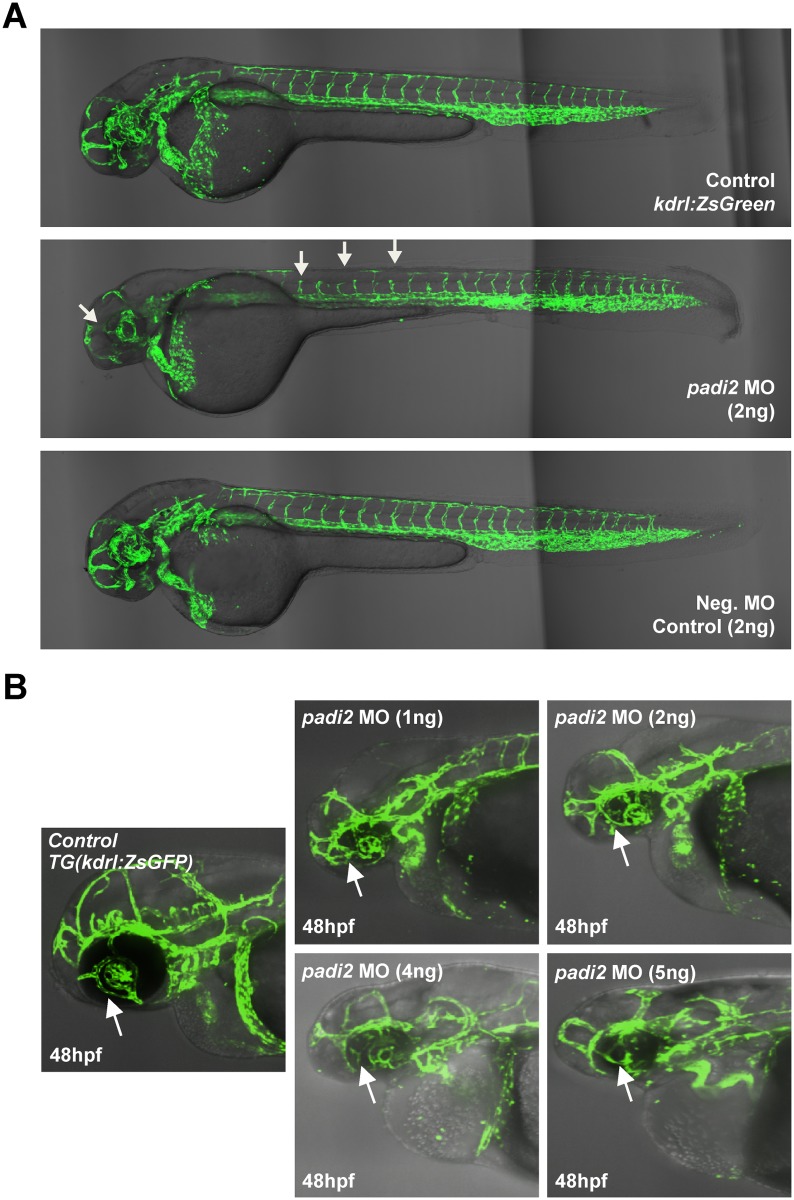
padi2 morphants display vascular defects at 48 hpf.A) Significant vascular defects in padi2 MO compared to sham-injected MO (negative) control siblings (representative figures from 16 injections, repeated 4 times). Note the gaps present in the intersegmental vessels suggesting missing or abnormal formation. Also note vessel absence in the head (arrows). Magnification: x10. B) Higher magnificantion imgages showing head vascular defects in embryos injected with zebrafish padi2 MO.